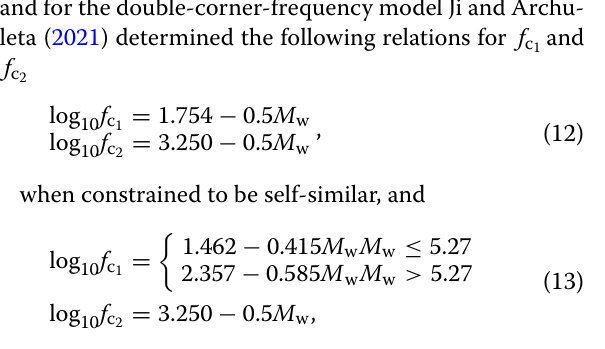
Figure 16 compares the distance-normalized ( R 10 km) PGA, PGV and f DOM from the lowest mis- = fit validation simulations with the BH14, JA19, and JA19_2S models. The median values for each simulated event are plotted as symbols with the error bars denot- ing the standard deviation. For the theoretical models, I have determined an optimal fit to the simulation results